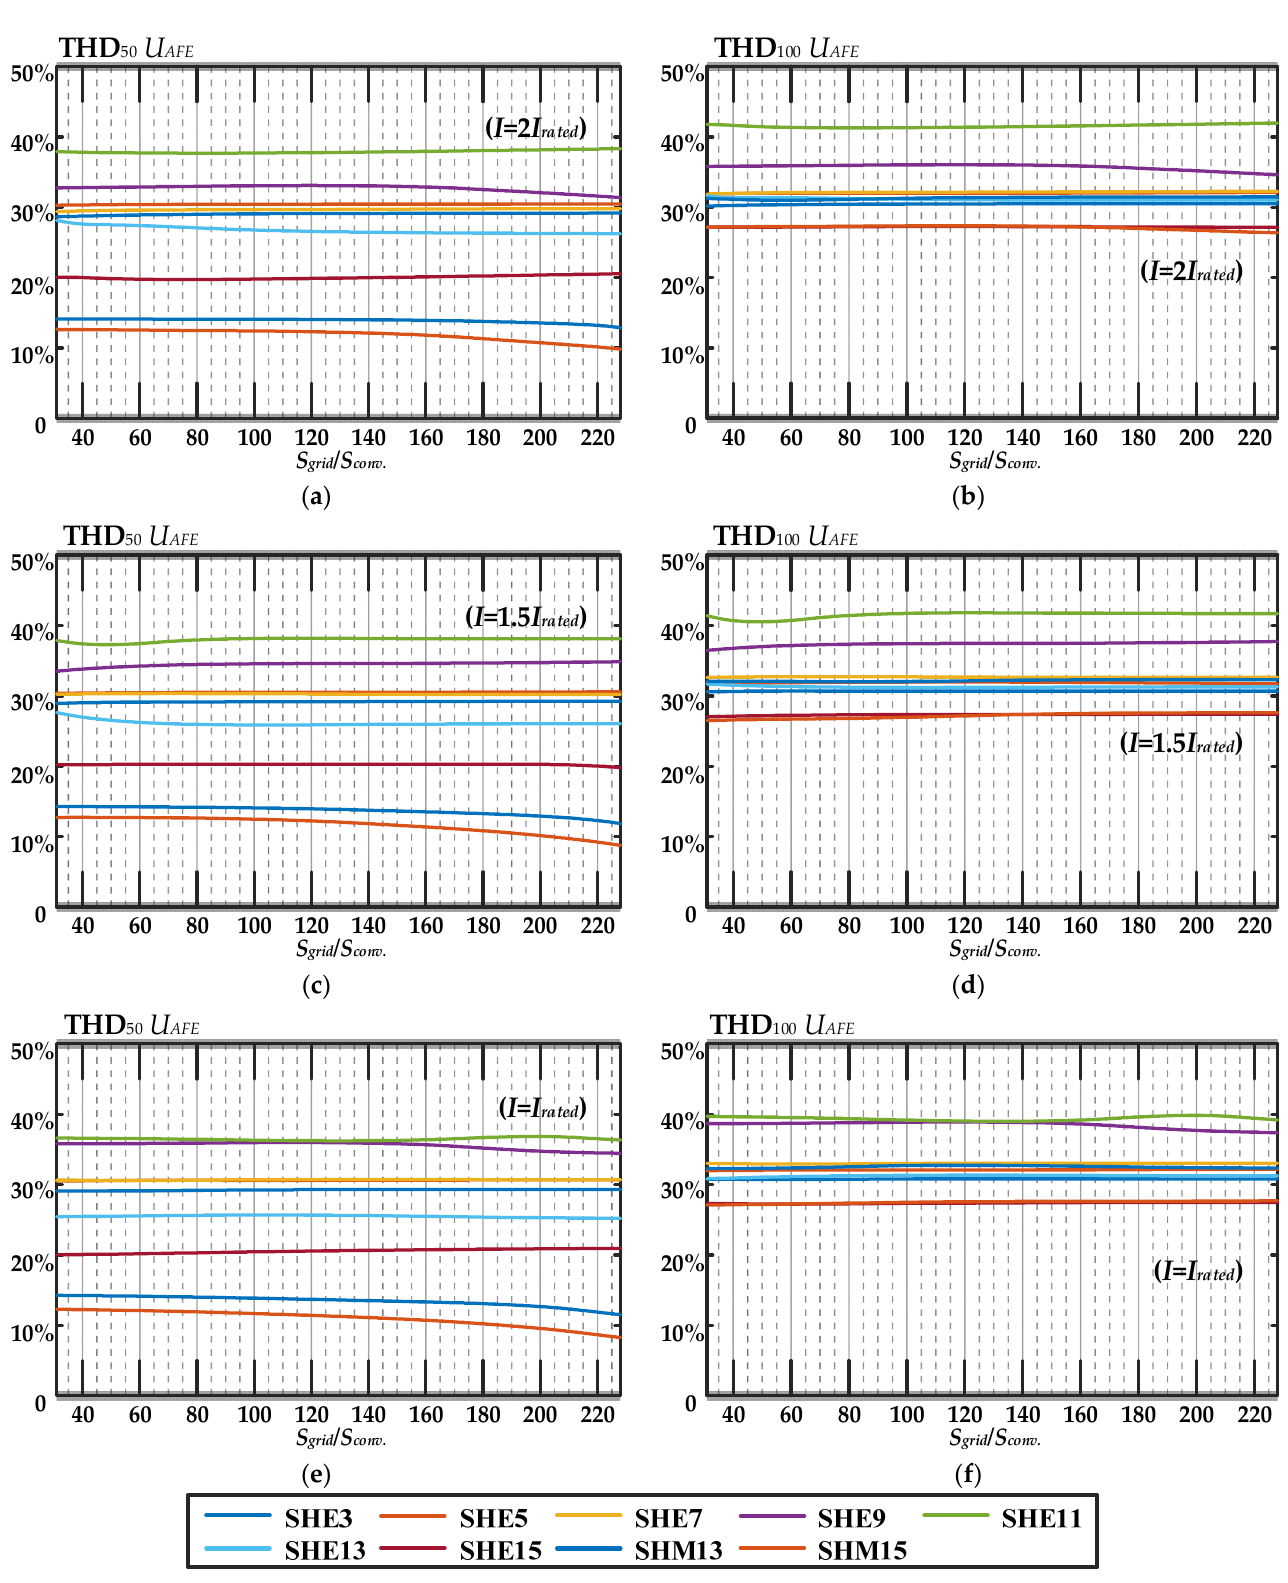
Figure 9. THD comparisons of U AFE between the harmonics up to the 50th order ( a – c ) and up to the 100th order ( d – f ).